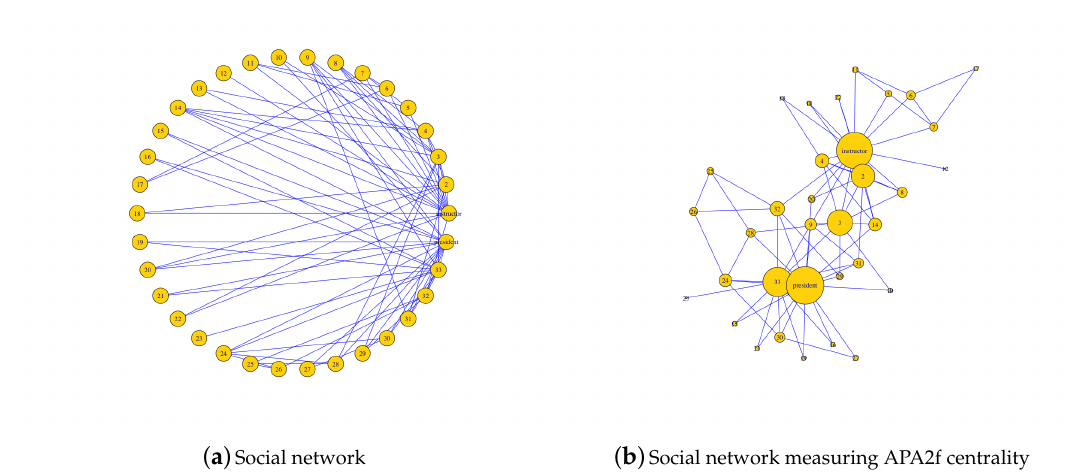
Figure 8. Applying APA2f centrality to Zachary’s karate